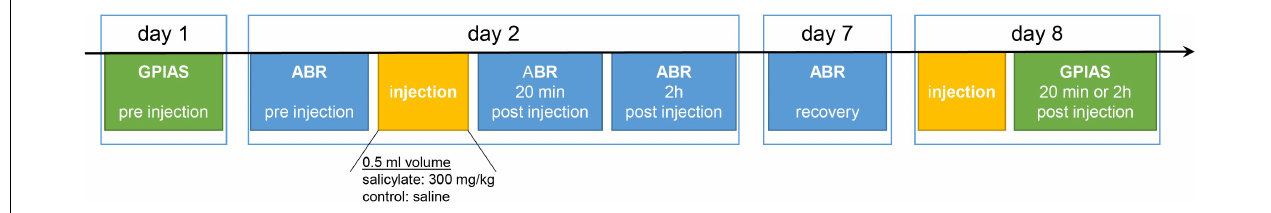
FIGURE 1 | Timeline of experiments. We first measured the baseline behavior in the prepulse inhibition (PPI) of the acoustic startle reflex (ASR) of each animal. The next day, we measured the audiograms, using pure tone ABR (pure tone hearing threshold, HT), first before the injection and, subsequently, 20 min and 2 h after the injection in both groups. After 7 days, we, again, measured the audiograms of the same animals. On the 8th day, we proceeded with a second injection of either salicylate or saline in the same (now awake) animals and obtained the 20-min or 2-h behavior response in the PPI of the